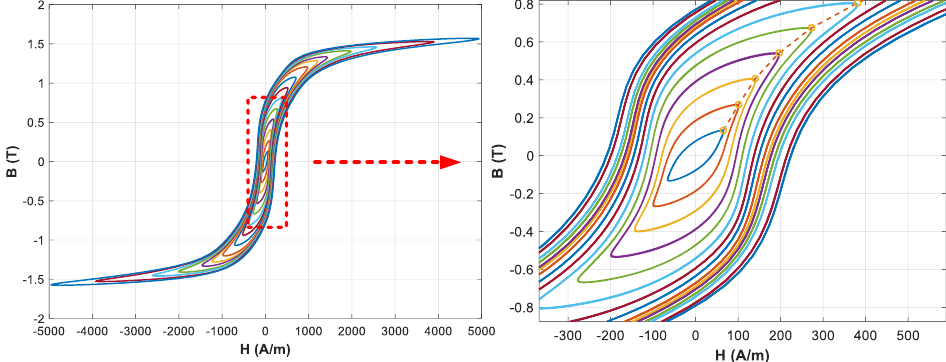
Figure 8. Measured B(t) and H(t) waveforms for a complete stator at different excitation levels at 400 Hz. ( a ) Magnetic flux density 0.1 T − 1.6 T. ( b ) Secondary voltage. ( c ) Magnetic field strength. ( d ) Primary current.